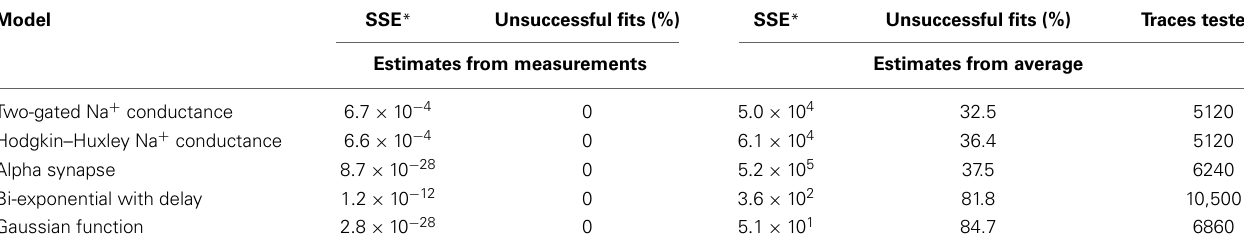
FIGURE 4 | Model fitting by least-squares optimization. (A) Average excitatory postsynaptic current (EPSC, in black) together with a fit to an alpha synapse model (red) with a rate of 3.4ms and amplitude of 13.7pA. (B) A single unitary excitatory postsynaptic potential (EPSP, in black) was fitted to a bi-exponential function (red) with time constants of 7.1 and 161.7ms, respectively. Cursors delimit the fitting regions. Measurements performed by Stimfit (e.g., baseline, peak) provide appropriate initial conditions to the fitting Table 3 | Impact of initial estimates on Levenberg–Marquardt fit results. Model SSE * Unsuccessful fits (%) SSE